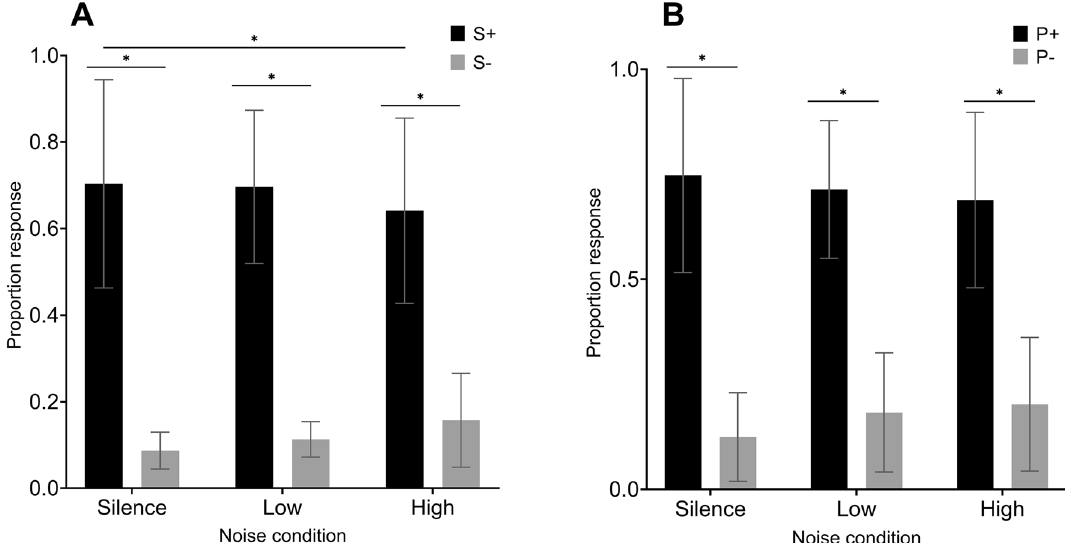
Figure 5. ( A ) Proportion response by True groups in Discrimination-85 with noise. S+ representing responses to rewarded stimuli and S− representing responses to unrewarded stimuli. The following differences were significant (indicated by asterisk): Silence (S+ vs. S−; p < 0.001, Low noise (S+ vs. S−; p < 0.001), High noise (S+ vs. S−; p < 0.001), and Silence vs. High (S+ vs. S+); p 0.017). Error bars represent standard error. ( B ) Proportion response by True groups in Probe trials with noise. P + and P- were based on whether stimuli was produced by the same birds as the S+ rewarded or the S− unrewarded stimuli. The following differences were significant (indicated by asterisk): Silence (S+ vs. S−; p < 0.001, Low noise (S+ vs. S−; p < 0.001), and High noise (S+ vs. S−; p < 0.001). Error bars represent standard